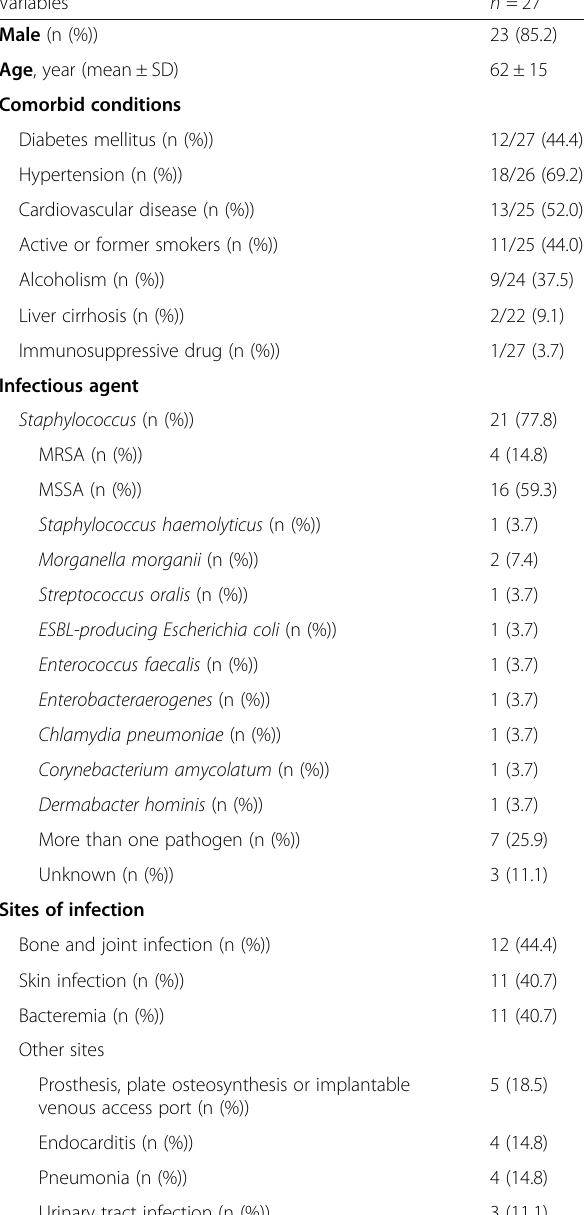
Table 1 Demographics, predisposing factors to infection and infectious